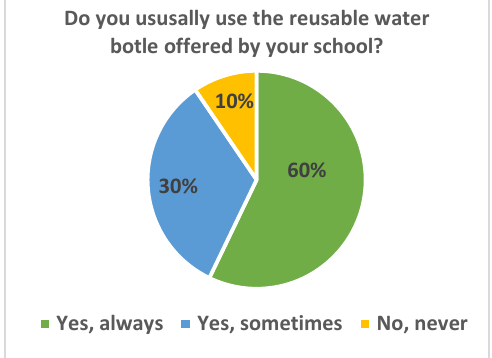
Figure 6. Use of reusable water bottle.